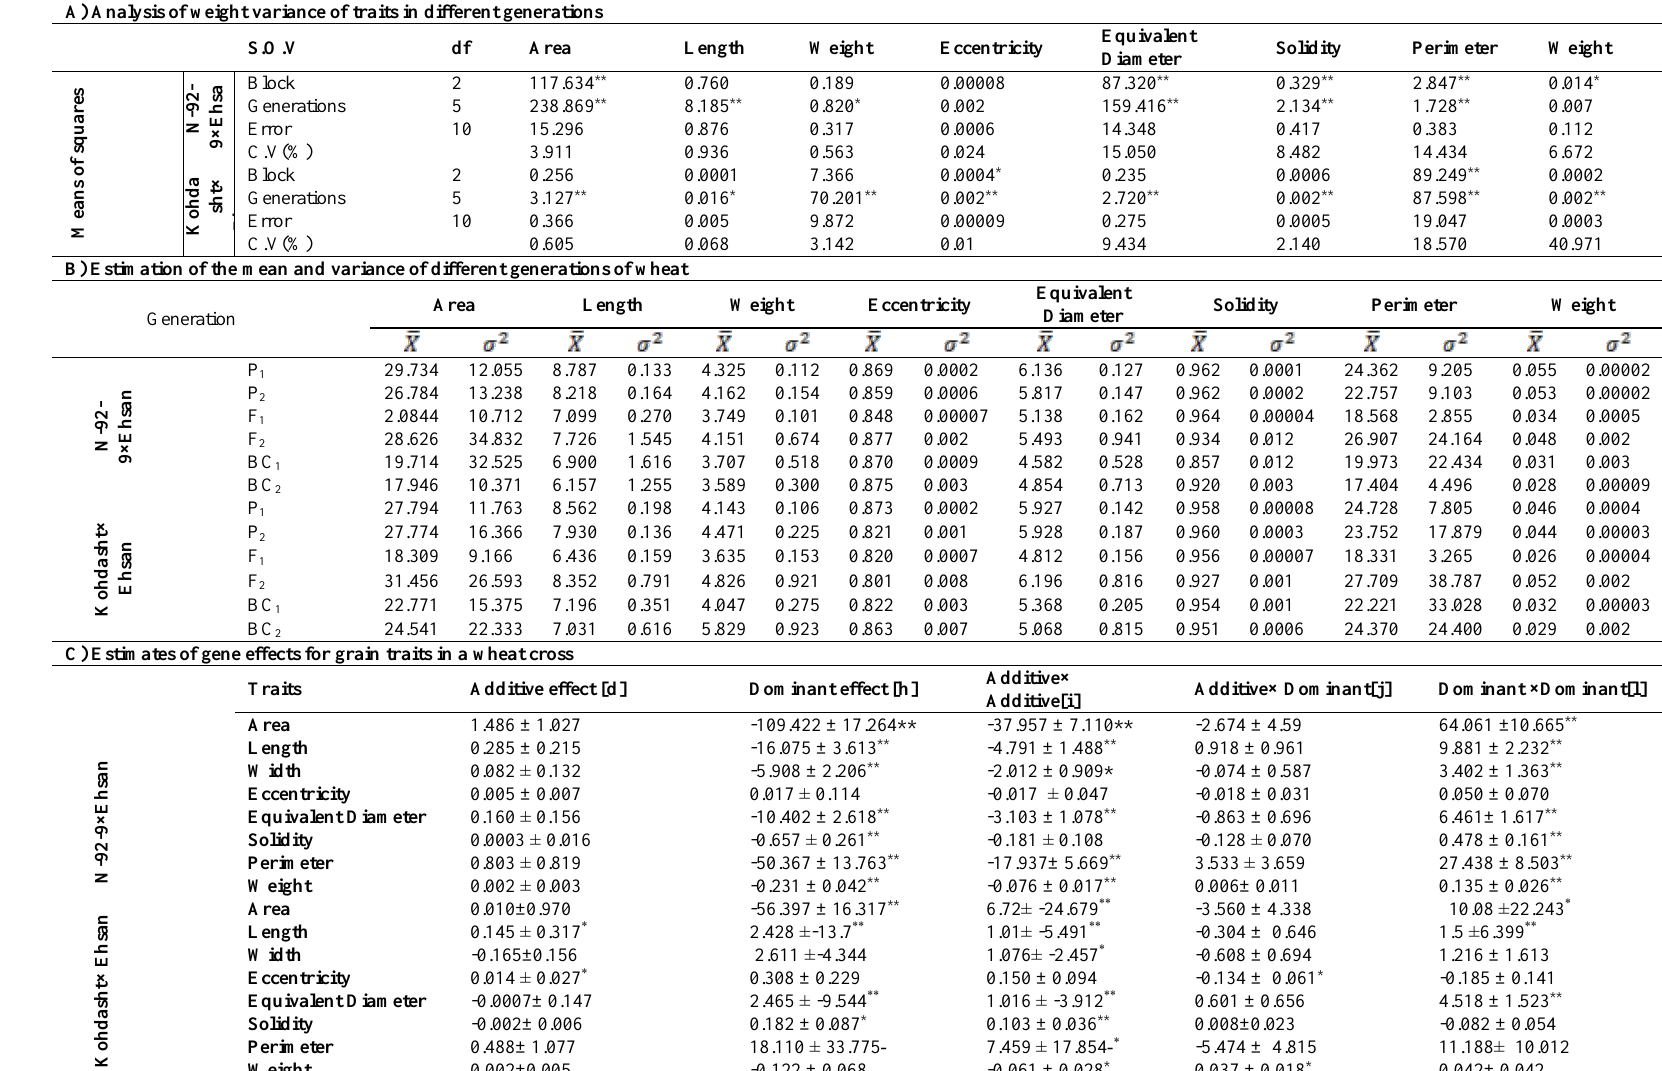
Table 1. Analysis of weight variance, estimation of the mean and variance and gene effects of the traits in different generations A) Analysis of weight variance of traits in different